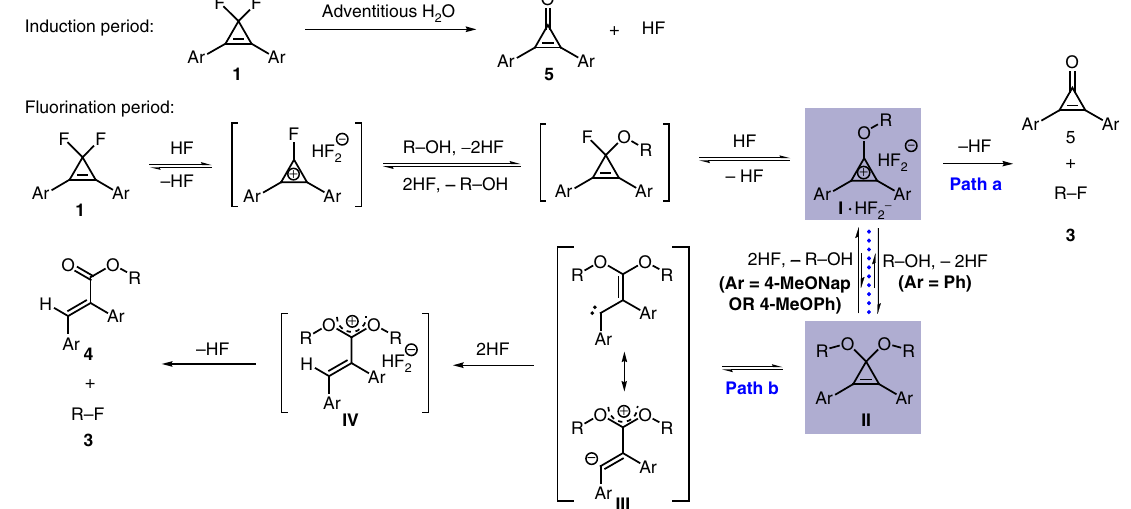
Figure 6 | Proposed mechanism for deoxyfluorination of monoalcohols with electronically different CpFluors. CpFluor 1 undergoes a reaction with monoalcohols to afford intermediate I . The stability of I that is determined by the electronic nature of the aryl substituents can significantly influence its reaction pathway (path a or path b) to give the corresponding